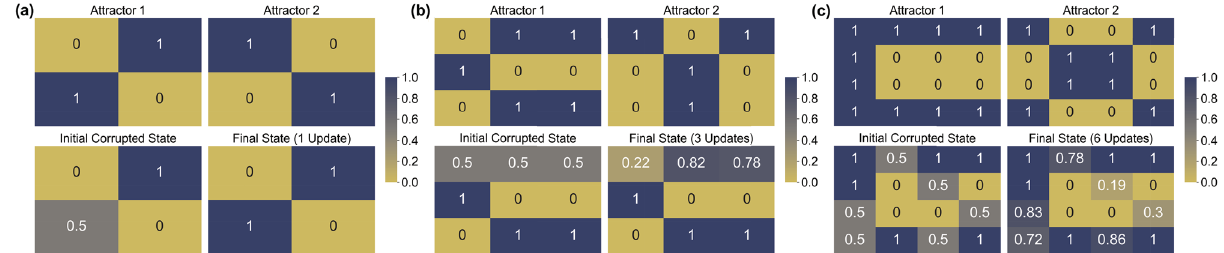
Figure 4. QASM simulation of QHAM of size 4, 9, and 16. Simulation results of the quantum Hopfield associative memory system for sizes ( a ) 4, ( b ) 9 and ( c ) 16 31 with two given attractor states. Each color graded box represents a qubit in each system state, and the number inside the box is the exact probability of measuring 1 for that individual | �